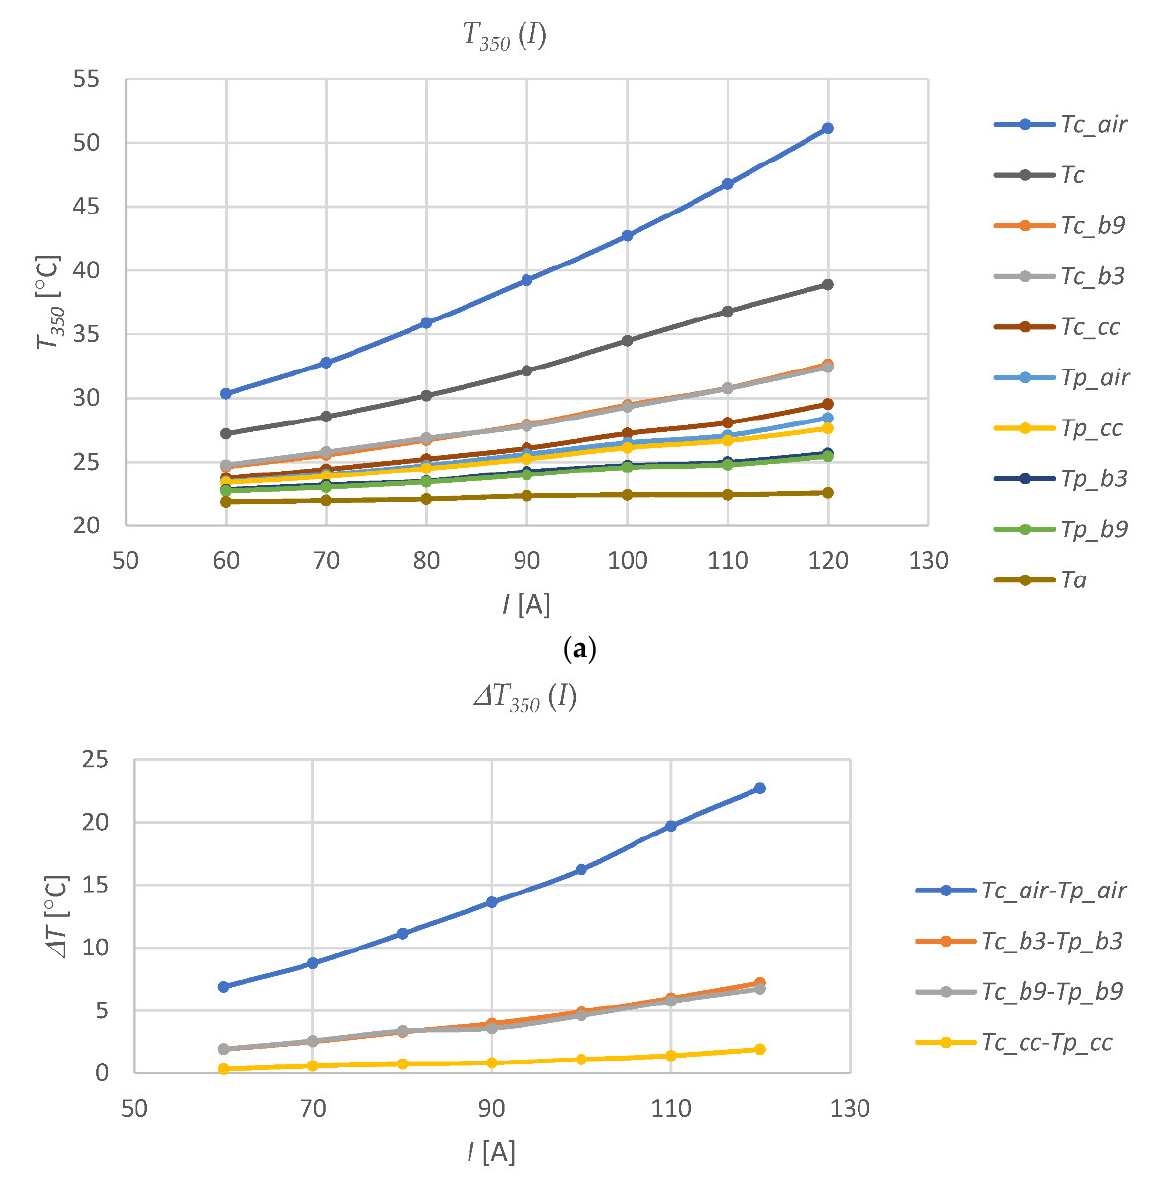
Figure 8. The graph of the values recorded at the 350th minute after switching on the current in the cable: ( a ) temperatures in the considered points of the test stand; ( b ) considered temperature differences ∆ T , in relation to the current supplying the cable.